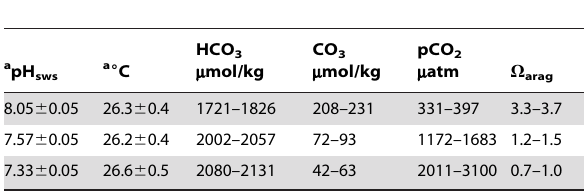
Table 1. Summary of physical and chemical conditions in each experimental